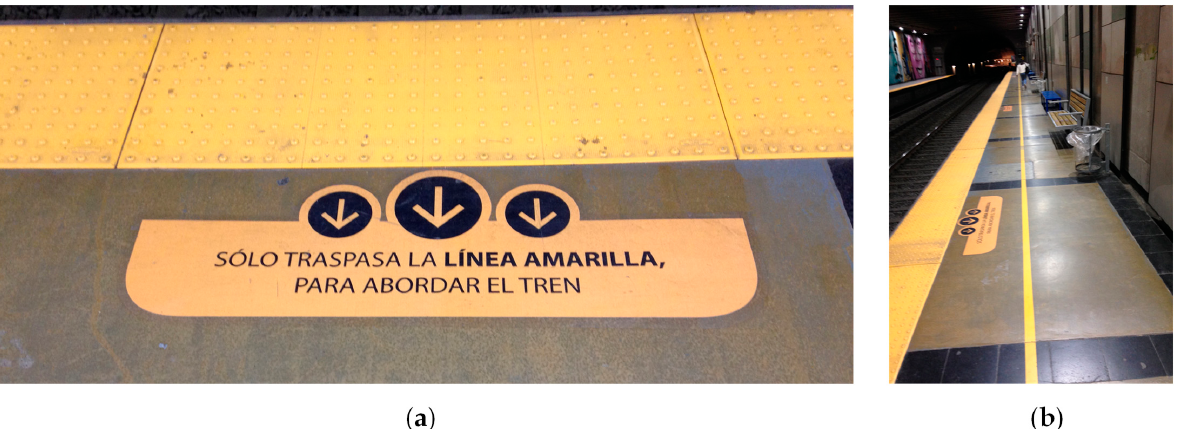
Figure 2. Laboratory experiments to represent the boarding and alighting: ( a ) lateral view of the platform when passengers are waiting to board the train and ( b ) top view of the platform when passengers are waiting to board the train.